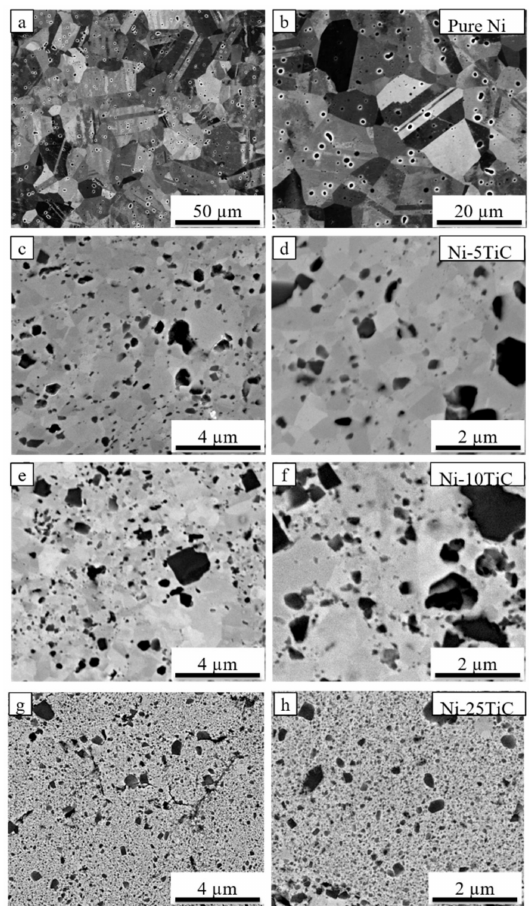
Figure 2. Scanning electron microscopy images of spark plasma sintered ( a , b ) Pure Ni, ( c , d ) Ni-5TiC, ( e , f ) Ni-10TiC, and ( g , h )